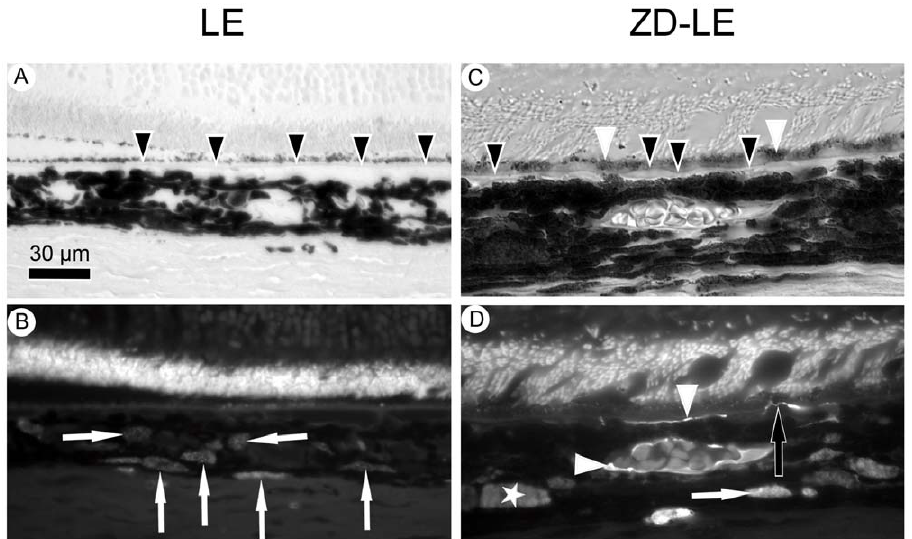
Figure 6. Light microscope and fluorescence micrographs of LE (A–B) and ZD-LE (C–D) rats. A ) Bright-field image of the retina - RPE – choroid complex in LE rat. Black arrowheads show the regularity of the Bruch’s membrane. B ) Fluorescence micrograph of ED1 positive cells in the same area as in (A). ED1 immunoreactivity (white arrows) is visible in the choroid. C ) Bright-field image of the RPE – choroid complex in ZD-LE rat. Black arrowheads show the irregularity of the Bruch’s membrane, white arrowheads indicate RPE cells. D ) Fluorescence micrograph of ED1 positive cells in the same area as in (C). Small ( , 3 m m) (white arrow) and large ( . 3 m m) (white asterisk) ED1 positive cells are detected in the choroid. ED1 immunoreactivity is also shown around choroidal blood vessels and along the choriocapillaris just below the Bruch’s membrane (white arrowheads). A thin ED1 positive cell simultaneously in contact with the Bruch’s membrane and a RPE cell (black arrow) is shown. In B and D), note the strong autofluorescence of the photoreceptor outer segments frequently observed in paraffin sections due to the fluorescence emitted by the retinoids reflecting the clearance of toxic byproducts and the accumulation of lipofuscin-like fluorophores associated with the increase of lipid peroxidation with age in the retina.